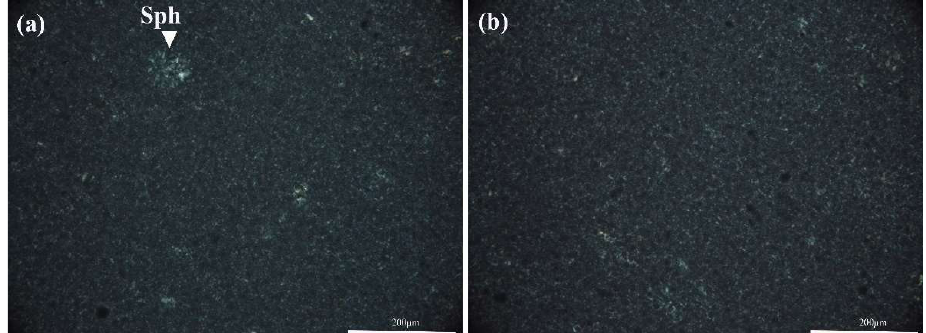
Figure 9. Photomicrographs in cross polarized light (XPL) comparing the textural characteristics of ( a ) inner part of nodule (MB1b); ( b ) a slightly more porous texture is evident for the outer surface (sample MB1a), (Sph: spherulite of a “ghost radiolarian”).